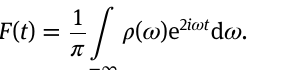
Figure 2: Rise-time dependence of time-reversal. (a) Dispersion relation for forward (continuous lines) and backward (dashed lines) waves before (blue) and after (red) the switching, illustrating the − 𝜔 − needed for time-reversal to frequency bandwidth Δ 𝜔 = 𝜔 + 1 2 occur. (b) Fourier transform (for 𝜔 > 0) of the derivative of the permittivity 𝜀 ( t ) for the three switching rise-times considered in Figure 1: time-reversal vanishes once the frequency content of the switching profile cannot bridge the frequency difference between theforwardwavebeforetheswitching,andthebackwardwaveafter. (c) Scattering intensities | R | 2 and | T | 2 of the time-reversed (left axis) and transmitted (right axis) wave as a function of the switching ∕ Z rise time (in log-scale). Note how the difference | T | 2 − | R | 2 = Z 1 2 is constant for any rise-time. The inset shows the sigmoidal step profile